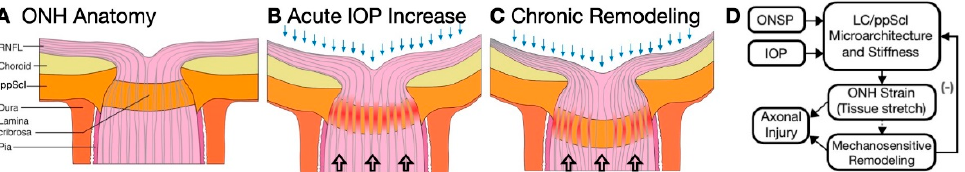
Figure 1. Mechanotransduction and optic nerve head remodeling. ( A ) Healthy optic nerve head (ONH) anatomy detailing key regions. ( B , C ) Increased intraocular pressure (IOP, blue arrows) is counterbalanced by optic nerve sheath pressure (ONSP, open arrows) resulting in tissue strain in the optic nerve head (ONH). This can damage axons directly (red) and activates cellular mechanotrans- duction that drives remodeling of the lamina cribrosa (LC) and peripapillary scleral (ppScl). ( C ) This remodeling alters the material properties and tissue architecture that modulates the stain that drives further remodeling. ( D ) This creates a negative feedback loop ( − ) that increases the vulnerability of the RGC axons to further glaucomatous injury. Deformation of any mechanical structure under load (strain) is determined by the loading forces (stress) along with its architecture and material